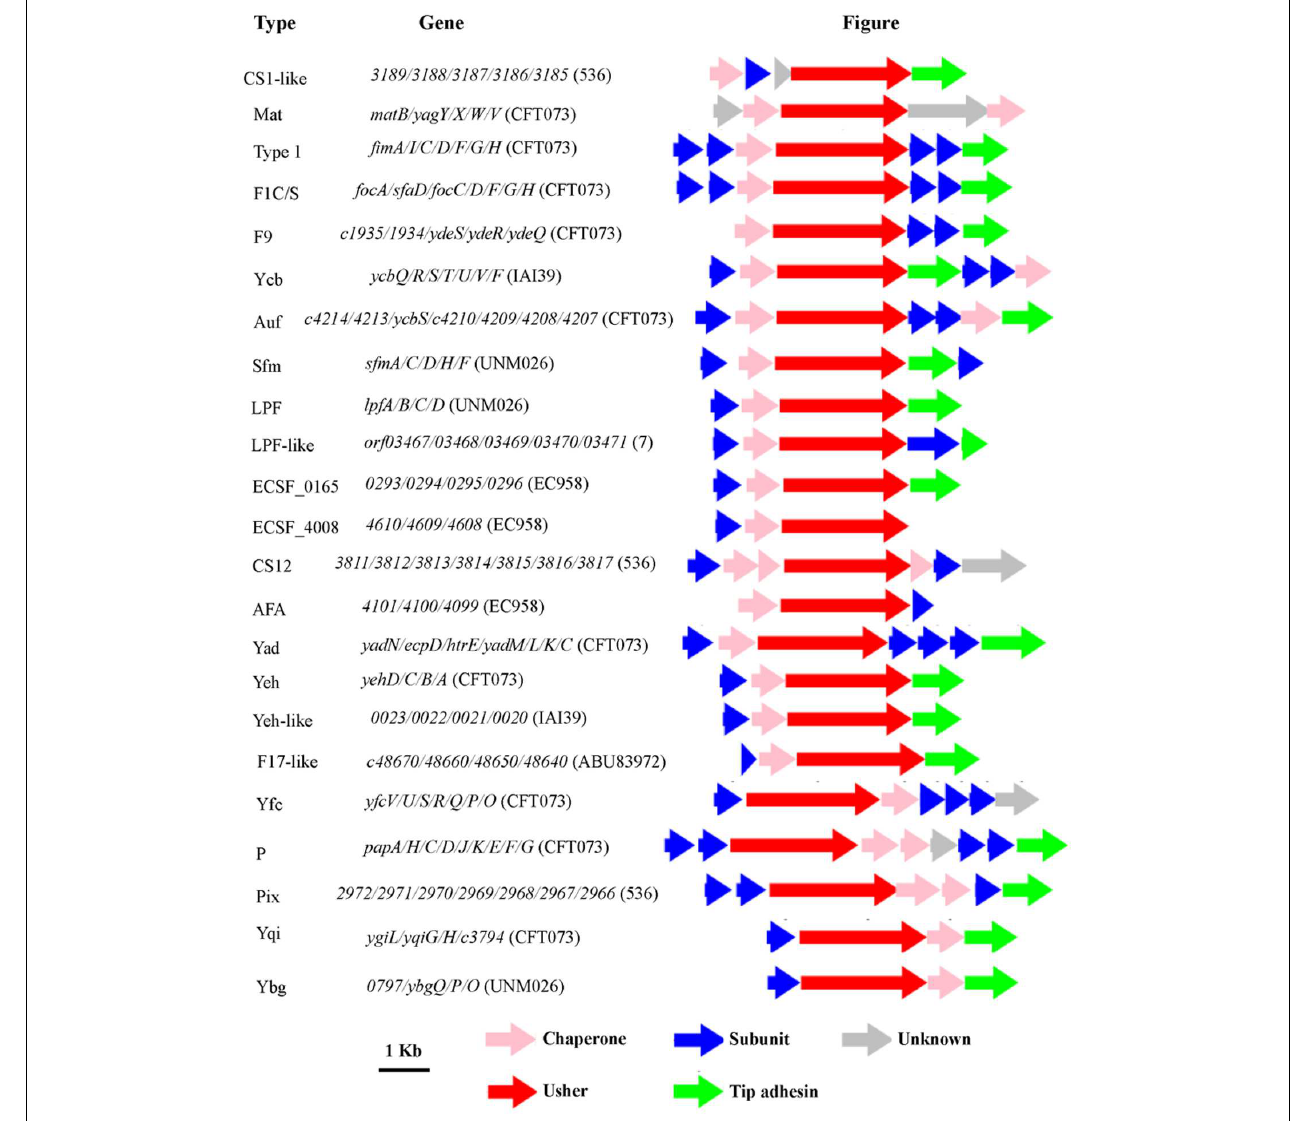
FIGURE 1 | The genetic organization of chaperone-usher fimbrial operons identified in 19 uropathogenic Escherichia coli (UPEC) strains in this study. The scale represents DNA length 1 kilo base pair. The type of fimbriae is indicated on the left, and the genes in each fimbrial operon are indicated in the middle. The direction of the arrow indicates direction of transcription of each gene, and the color of the arrow indicates the gene function (key shown below the